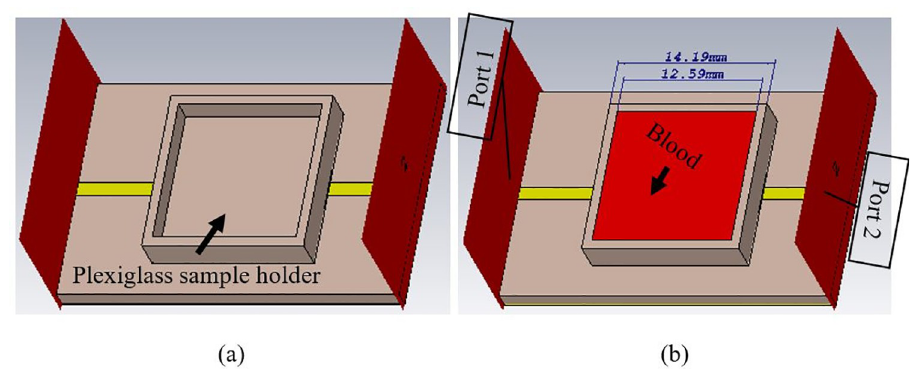
Fig 2. Designed structure with sample holder (a) without blood sample and (b) blood sample.